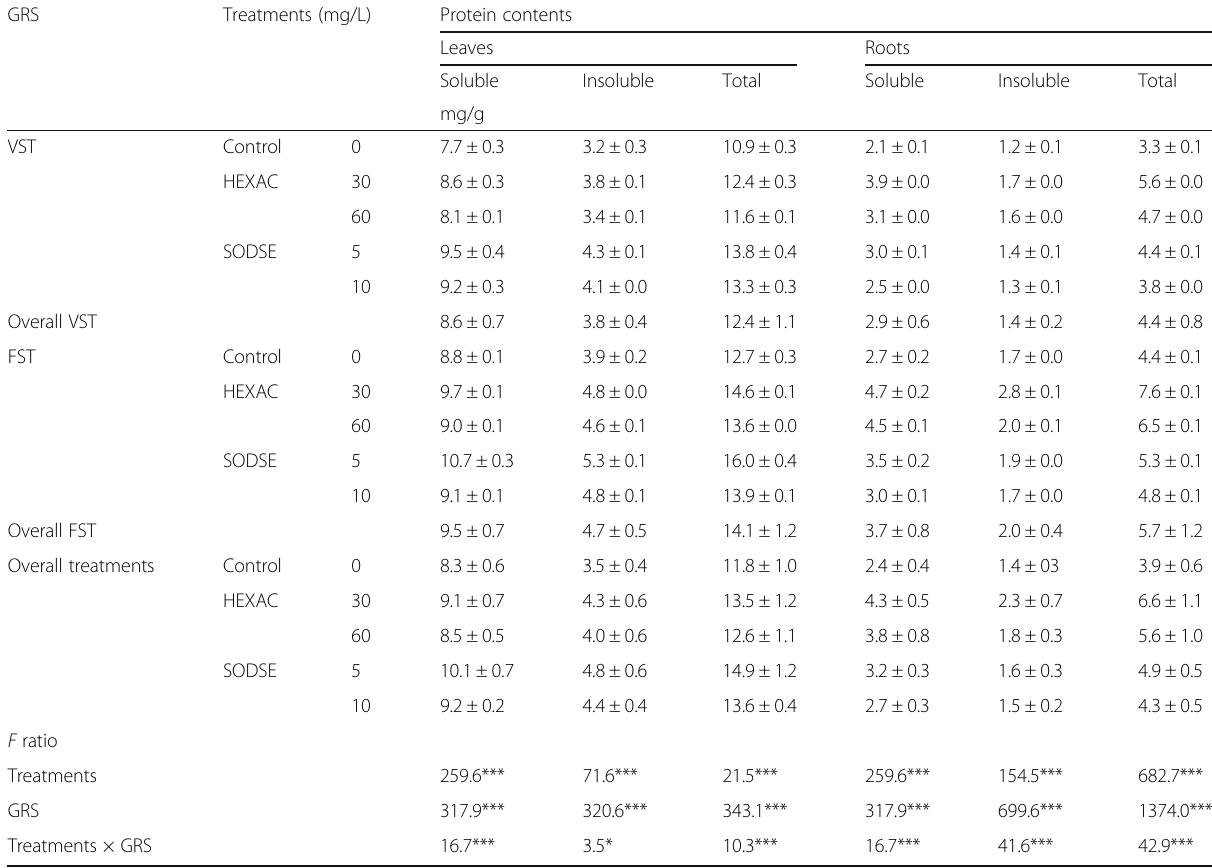
Table 4 Effect of HEXAC or SODSE on the proteins content GRS Treatments (mg/L) Protein